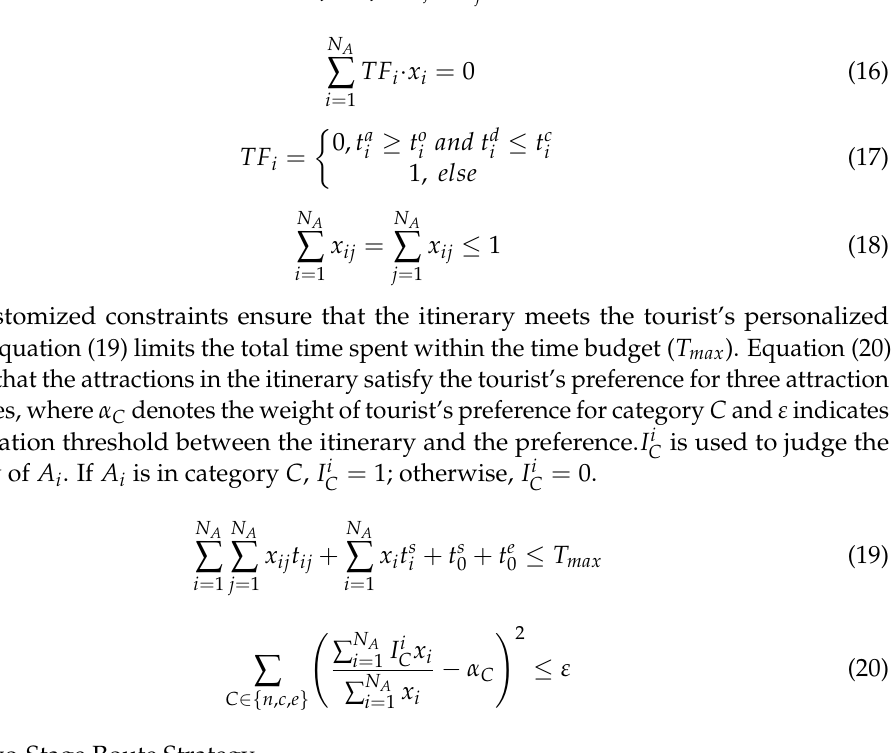
Figure 4. Representation of the chromosome and evolutionary operators: ( a ) container-index coding and decoding; ( b ) partial-mapped crossover operator; ( c ) mixed mutation operators.